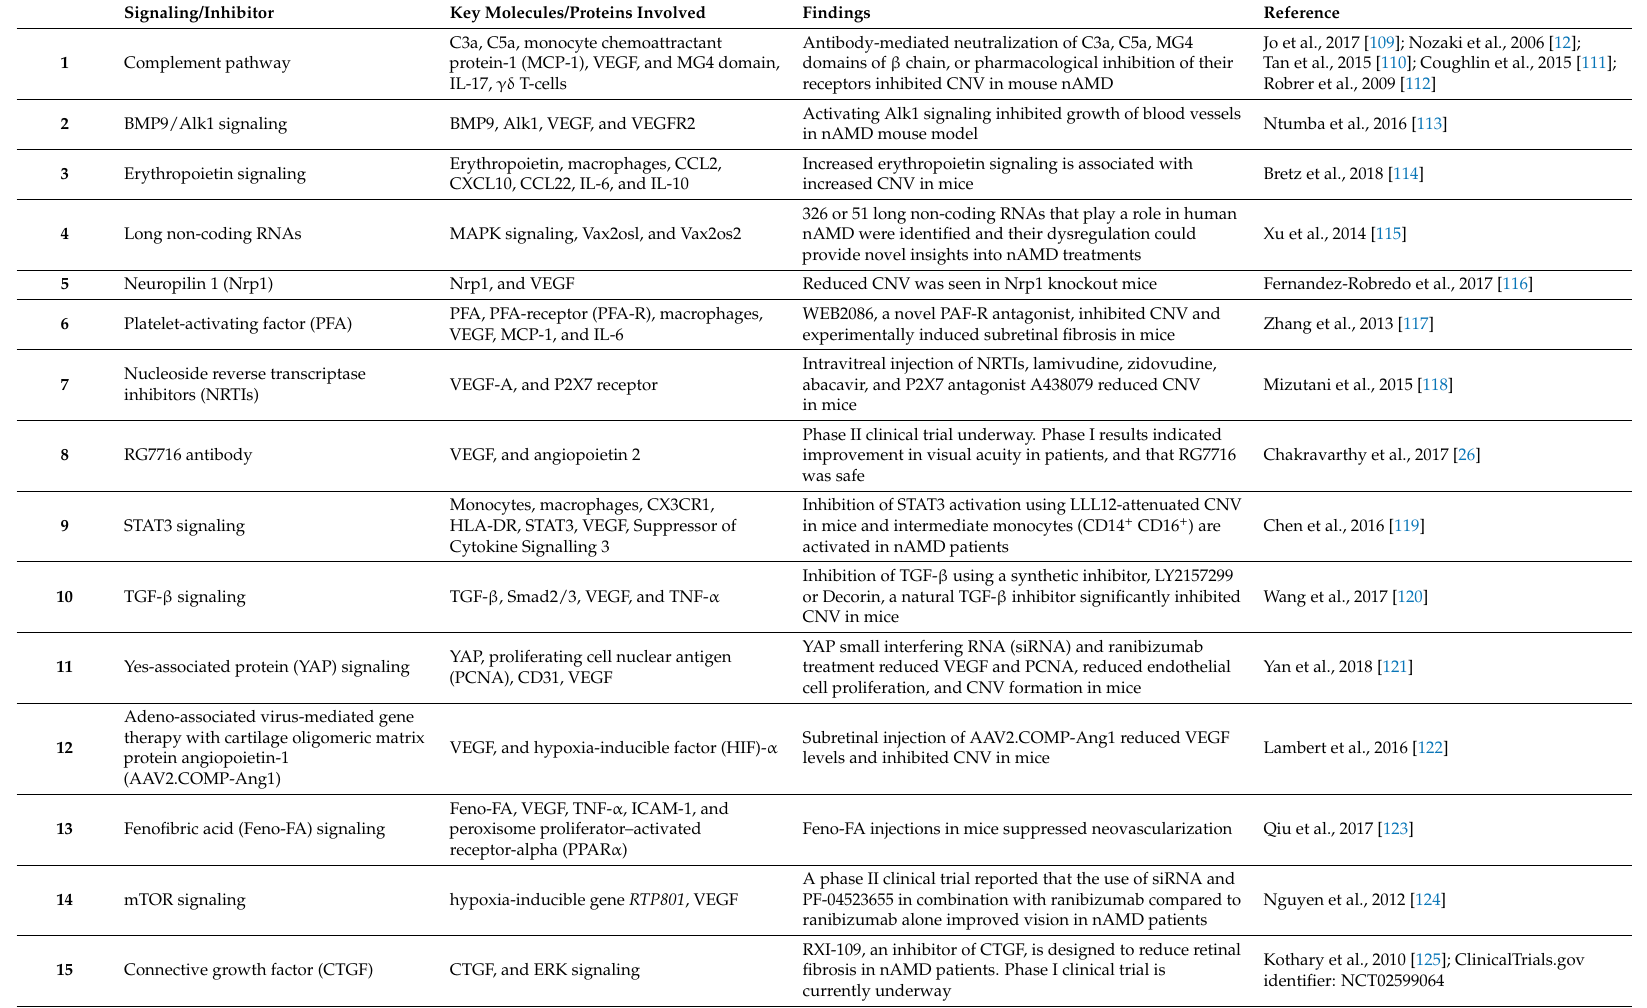
Table 1. List of potential targets for nAMD treatment partially involving